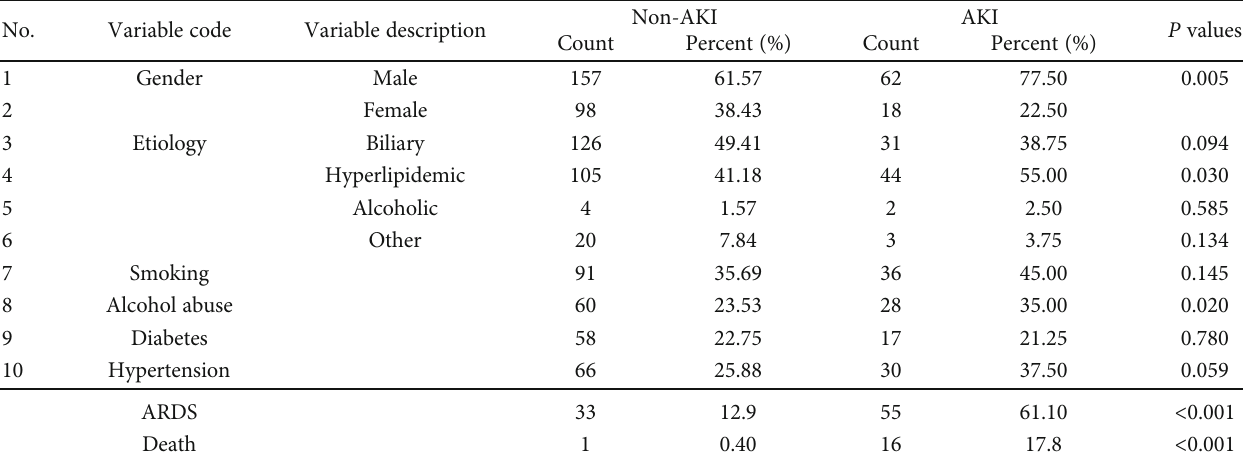
Table 2: The dichotomous variable characteristics and outcomes of AP patients.